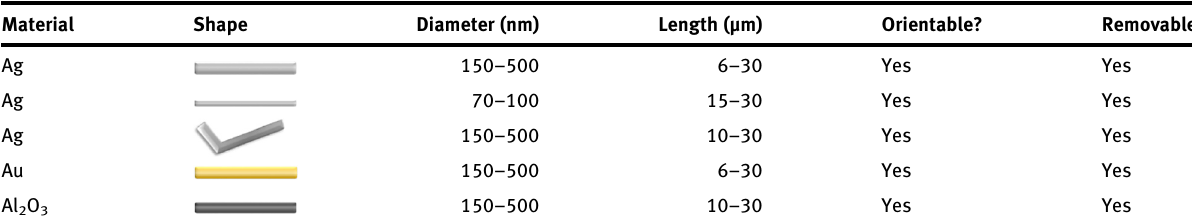
Table  : The geometrical characteristics, properties, and manipulating behaviors of nanowires.